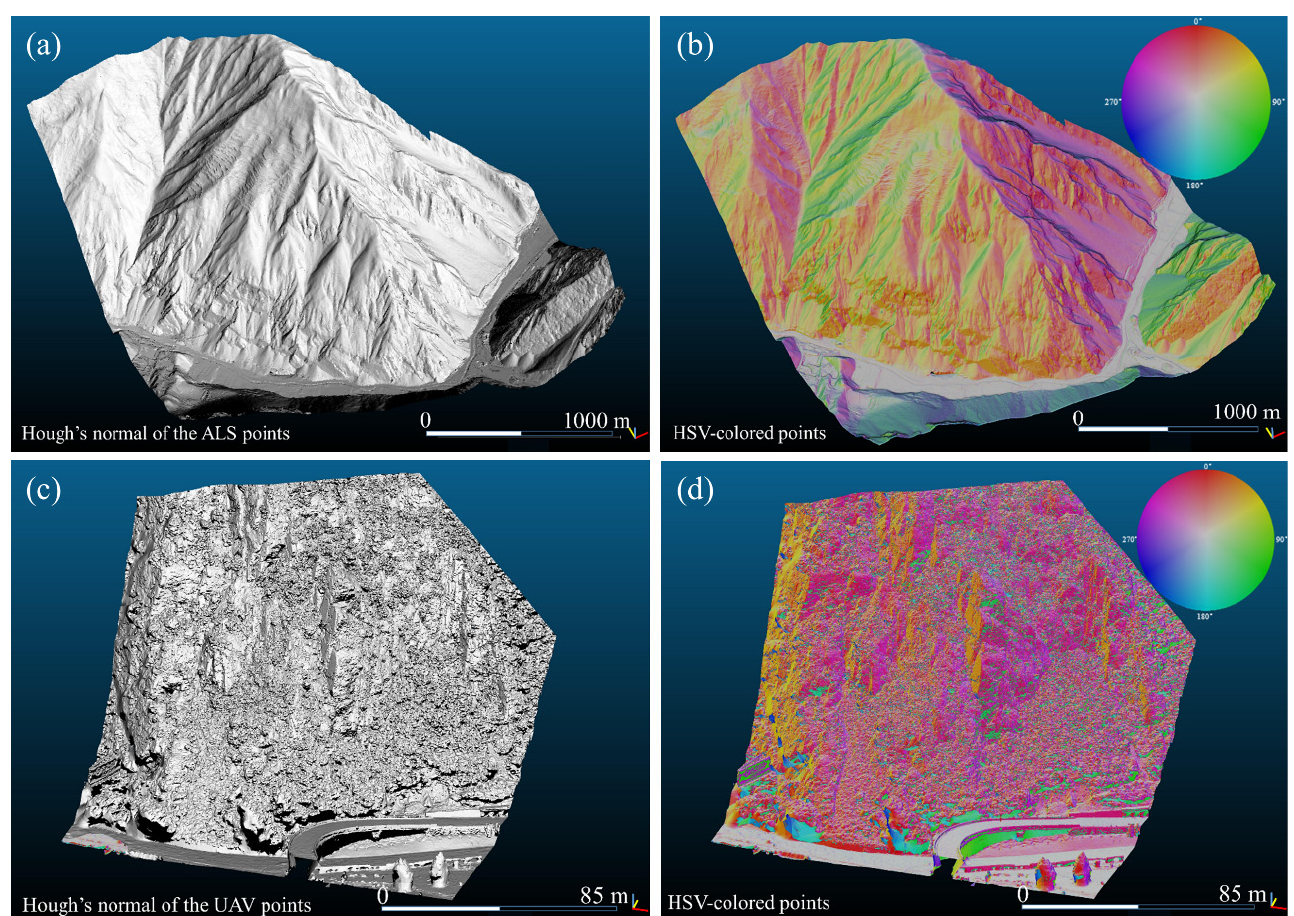
Figure 6. ( a , c ) Rock structure rendered based on Hough’s normal of the ALS and SfM points; ( b , d ) rock structure identified based on the ALS and SfM points coloured according to Hough’s normal using HSV wheel.